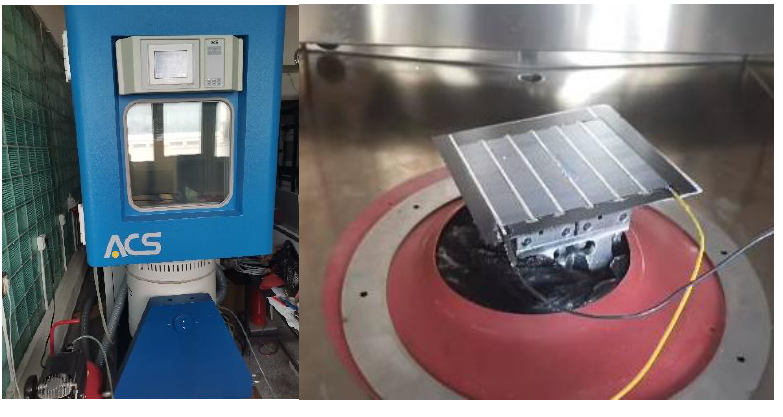
Figure 11. Angelantoni climatic chamber with Tira S55240/LS vibration test stand and demonstrator installed on the shaker table.